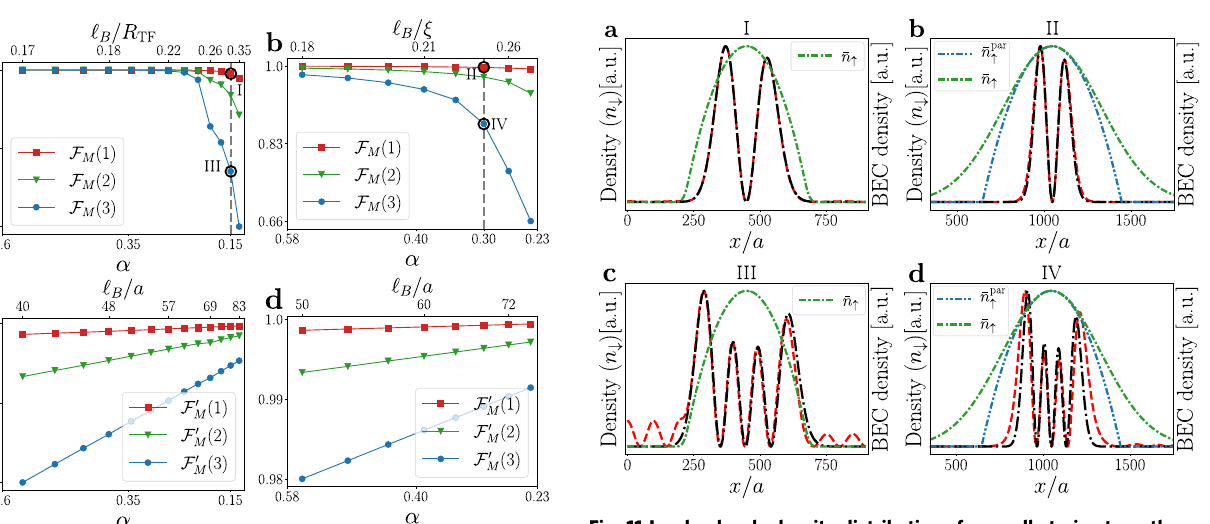
Fig. 11 Landau levels density distributions for small strain strengths. Density from the eigenvectors of (long dashed-dotted) ^ H eff and (dashed) # ^ H q y a = 0 and 0 corresponding to the circles indicated in Fig. 10a, b for ( a , b ) ( c , d ) q y a = − 0.00067. In all panels, we plot only the A component. The single-dashed and double-dashed lines represent the numerical solution of par the Gross – Pitaevskii equation (cid:2) n and the parabolic pro fi le (cid:2) n that " " approximates the Gaussian at its maximum,